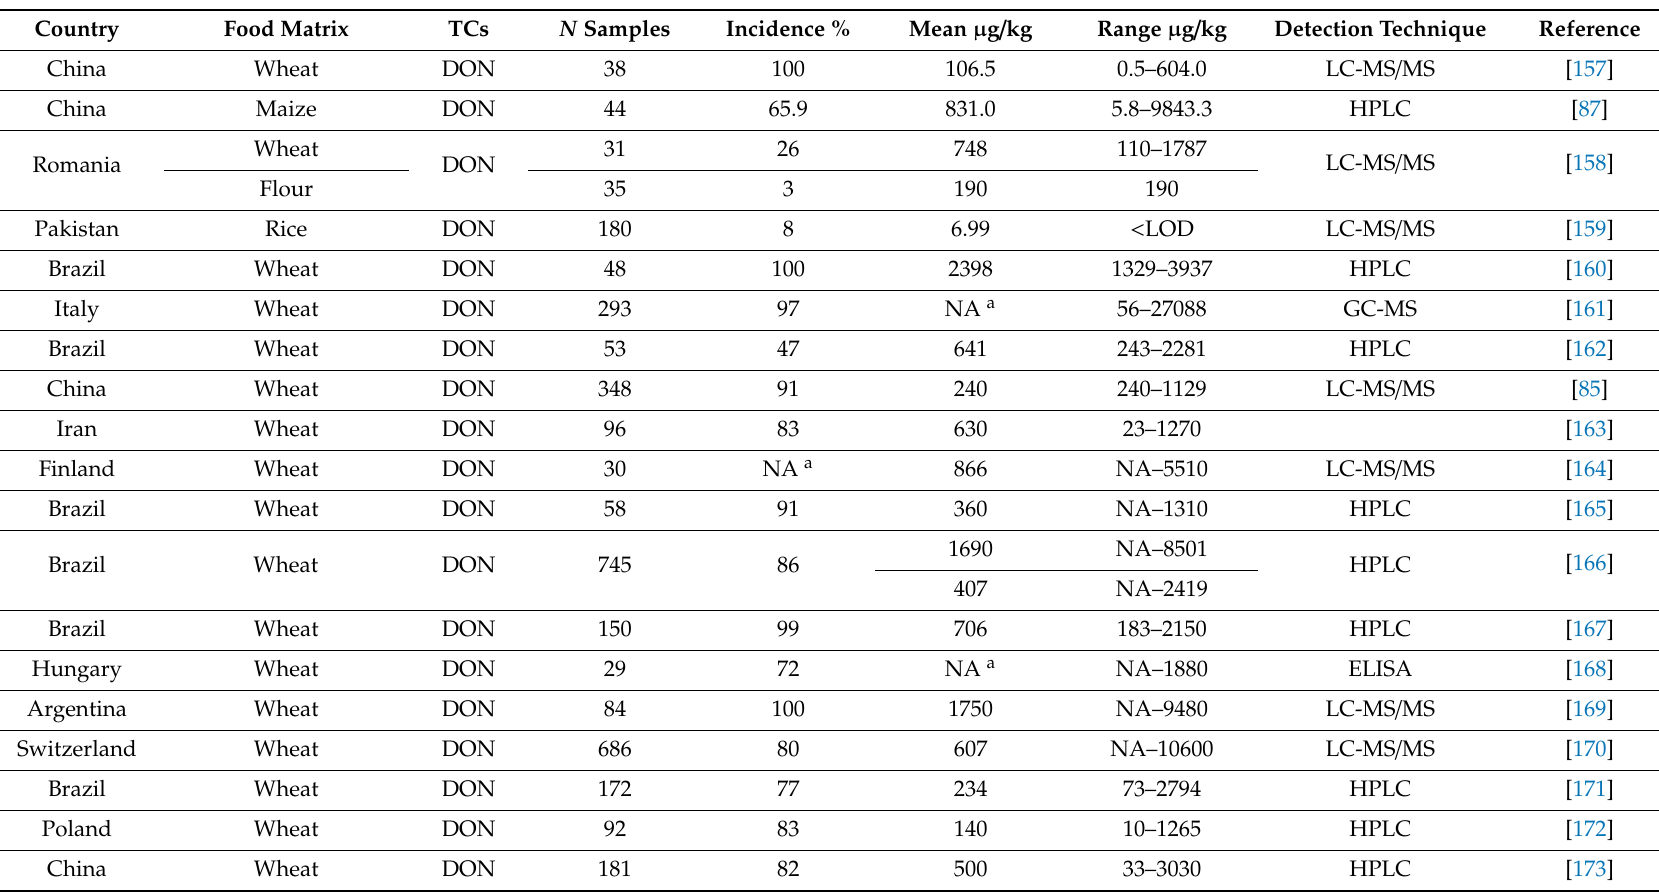
Table 7. Representative studies on the occurrence of trichothecene (TC) distribution ( µ g / kg) in food samples around the world during 2014–2019.